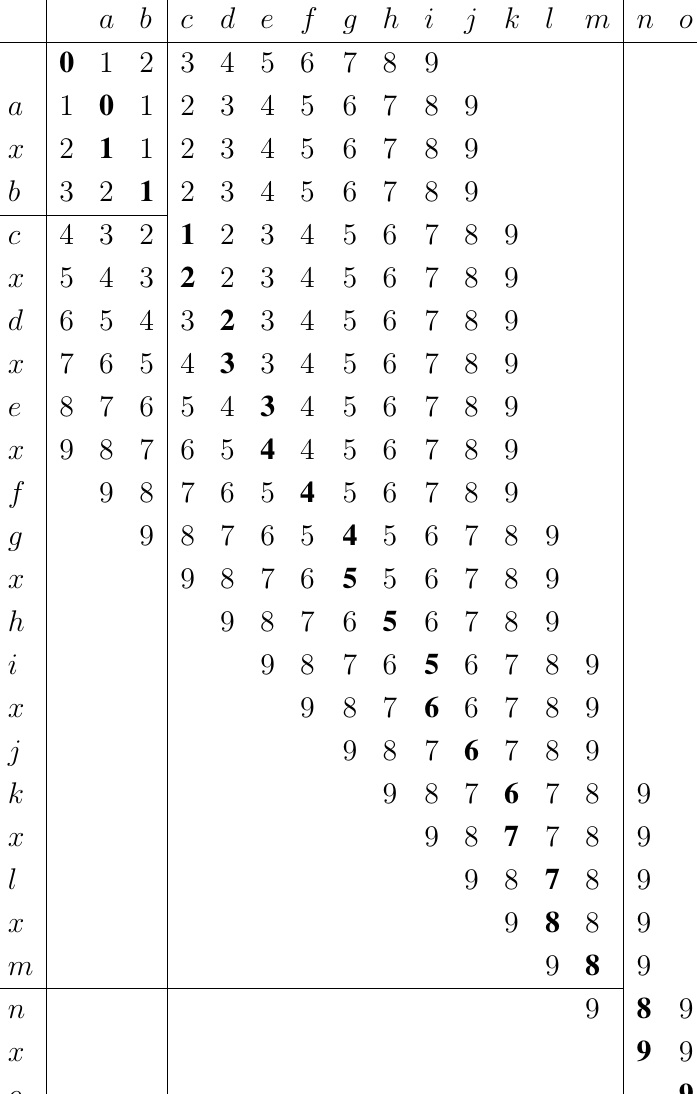
Figure 5. Dynamic programming table D for strings, B = P = axbcxdxexfgxhixjkxlxmnxo (vertical) and A = O = abcdefghijklmno (horizon- tal) with k = 9